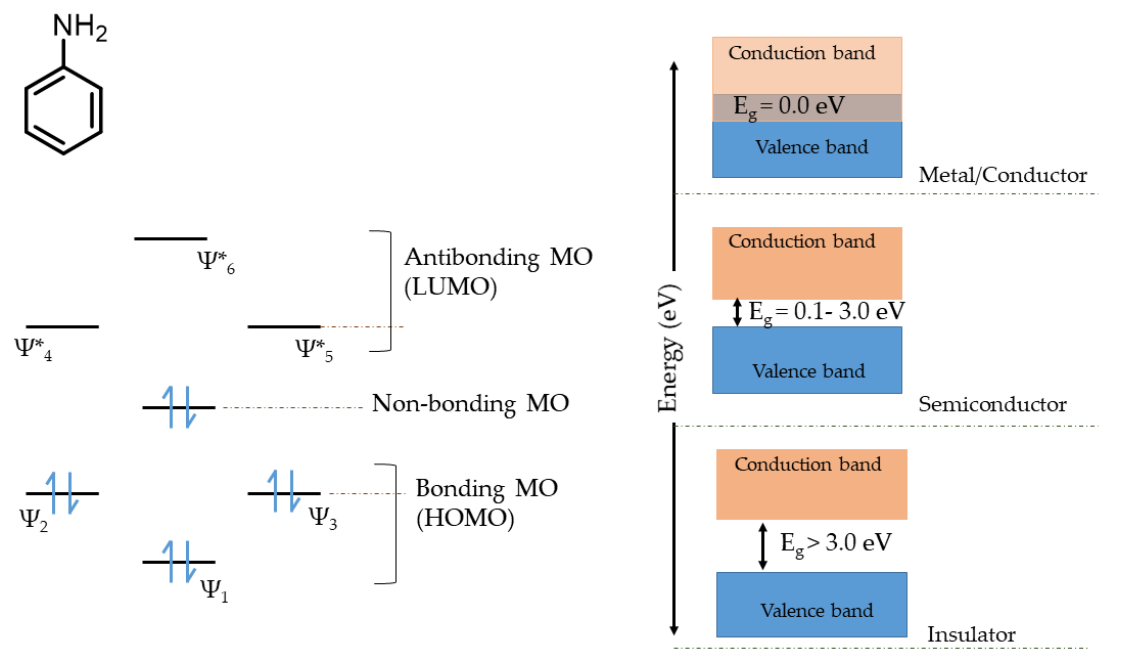
Figure 13. MO diagram of π -orbitals in aniline molecules and overlapping of energy bands in a conducting material.